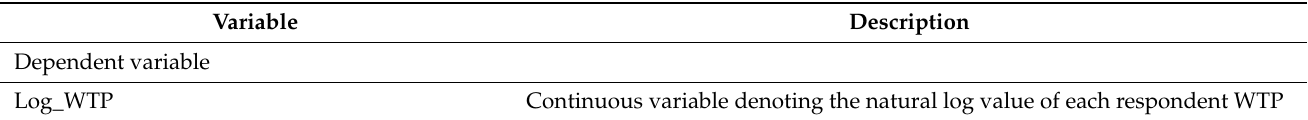
Table 7. Description of variables used in regression